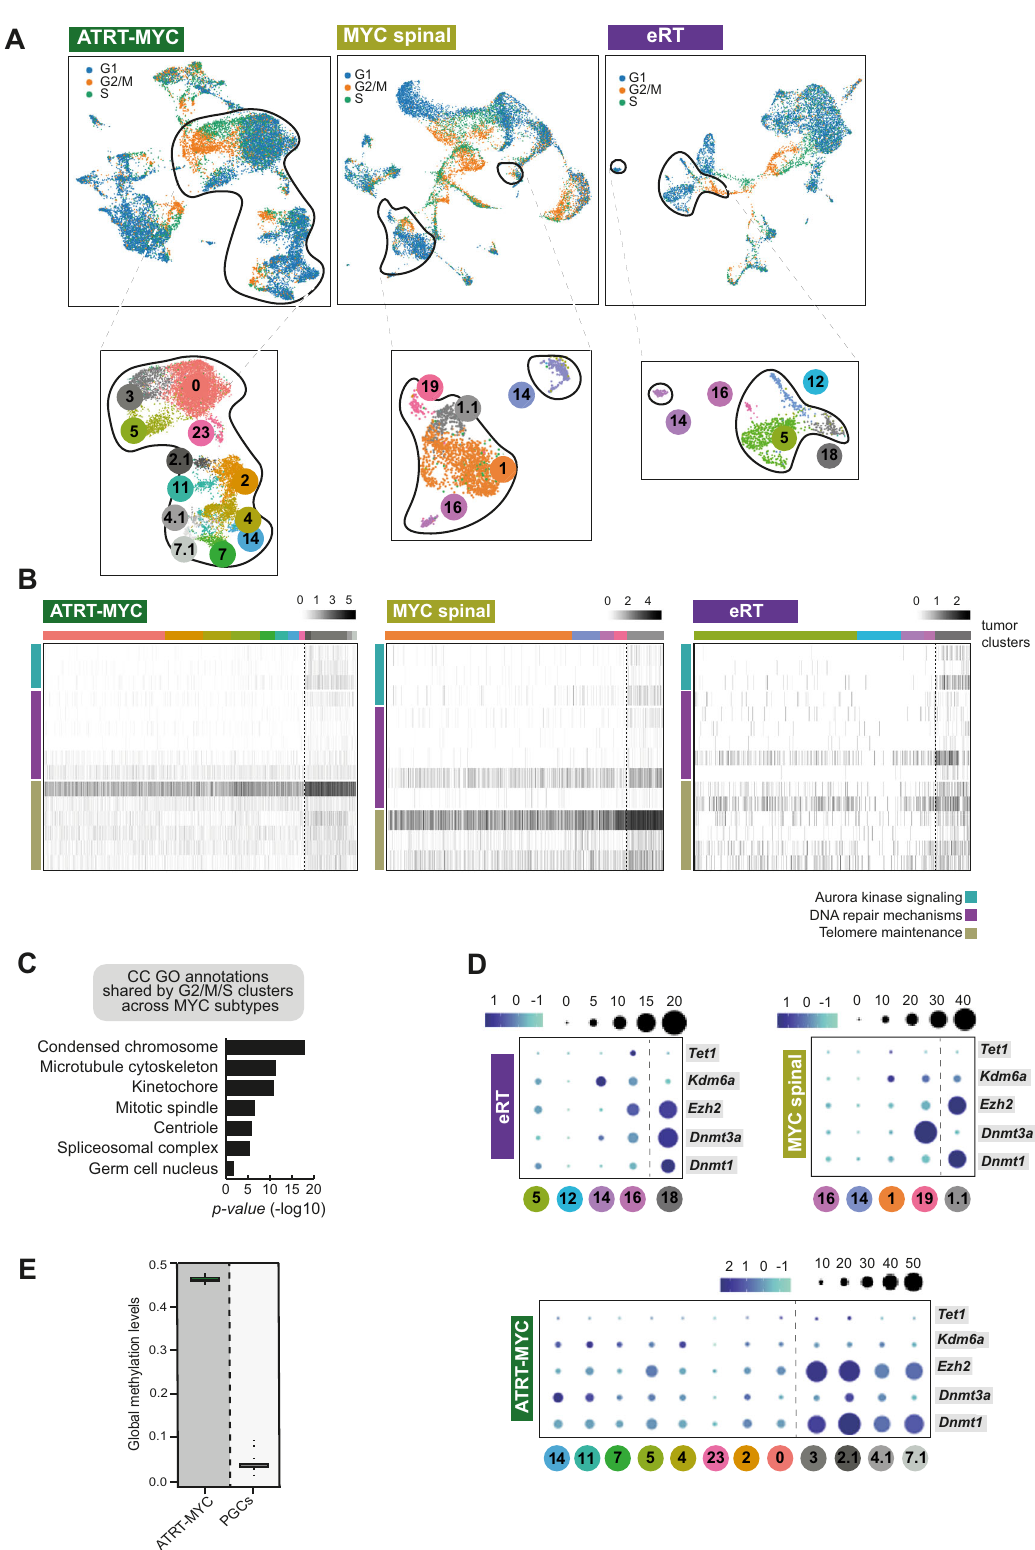
Condensed chromosome Microtubule